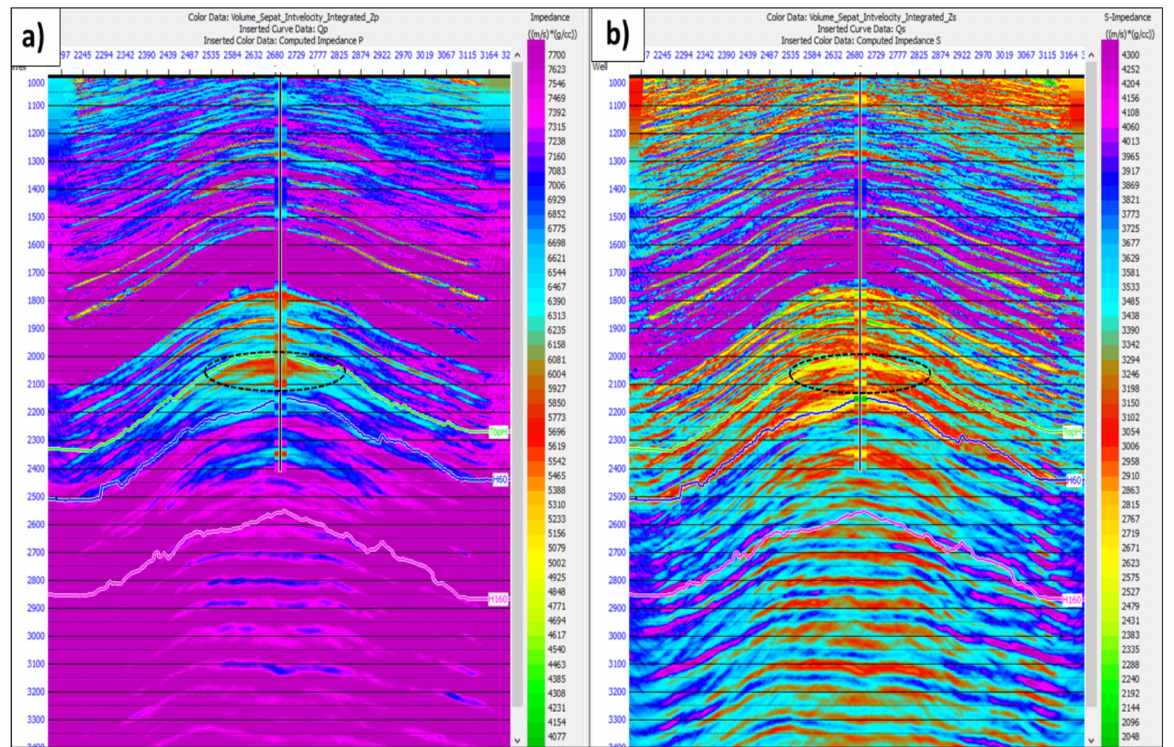
Figure 17. ( a ) Inverted Zp crossline section containing XD-2 well from pre-stack simultaneous inversion; ( b ) Inverted Zs crossline section containing XD-2 well from pre-stack simultaneous inversion.